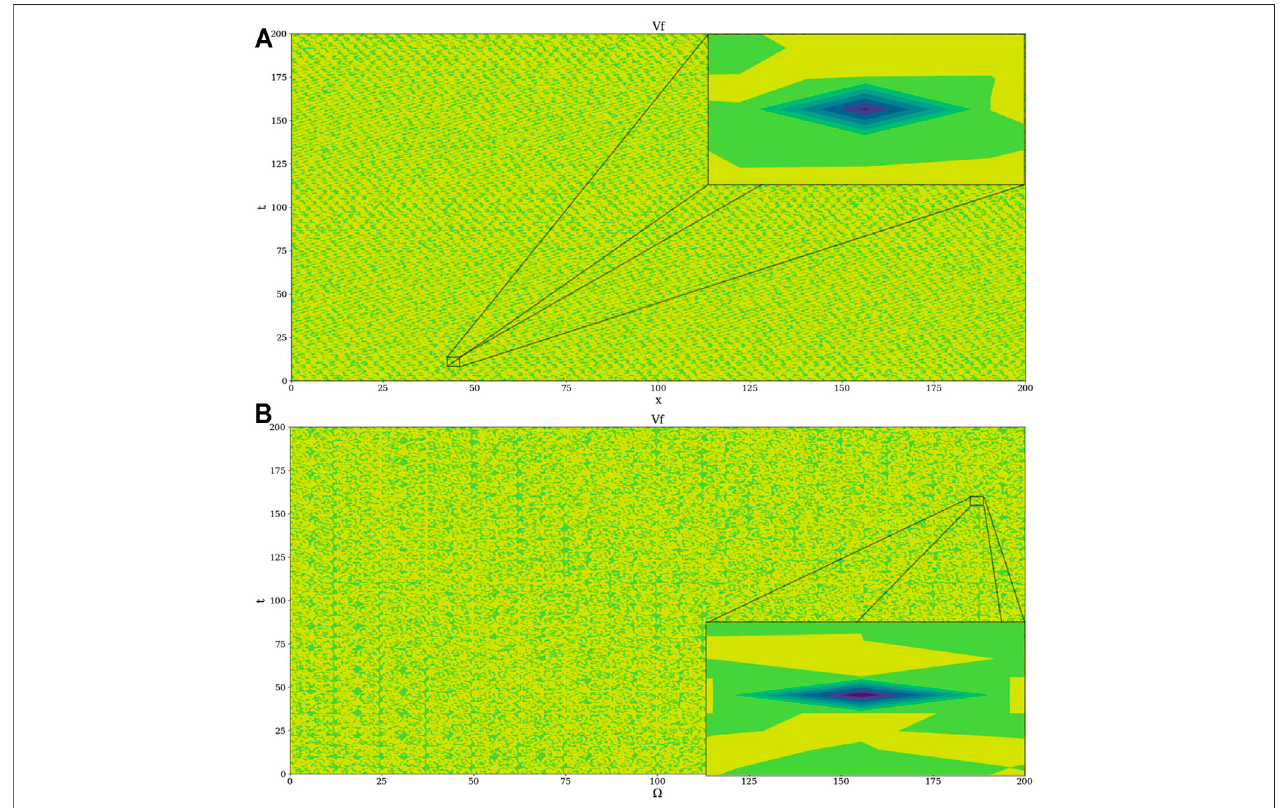
FIGURE 8 | Example 2D plot of V F ( x , t ) ; (A) zoom-in of spontaneous symmetry break peak (top-right); Ω (cid:2) 2 . 1, Φ (cid:2) 2 . 35, (B) zoom-in of spontaneous symmetry break peak (bottom-right); x (cid:2) 5, Φ (cid:2) 2 . 35.